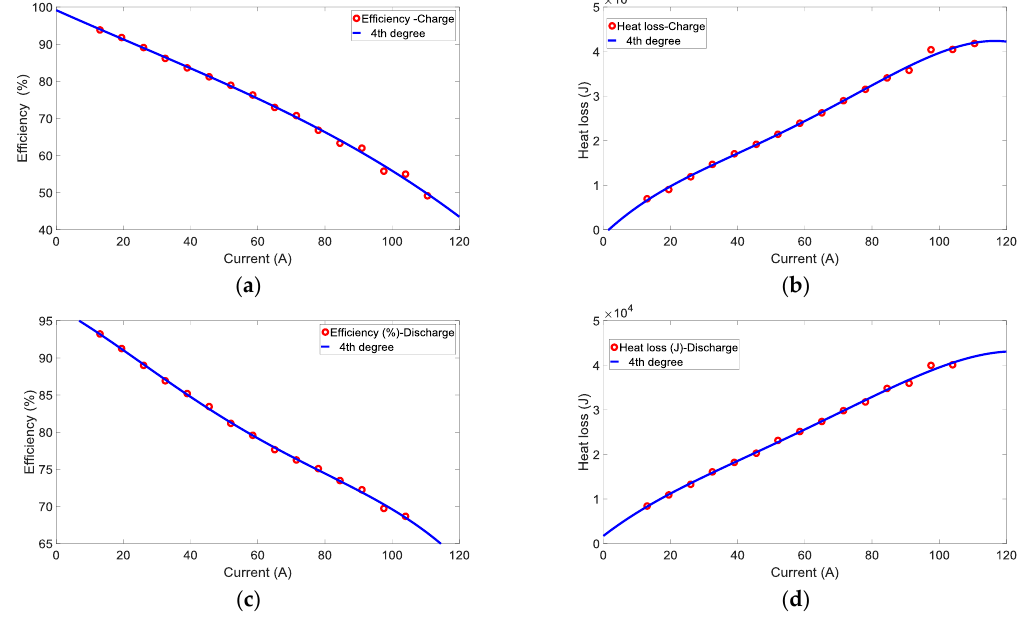
Figure 12. Efficiency and heat loss evolution and their curve fitting during charge and discharge. ( a ) Efficiency-Charge; ( b ) Heat loss-Charge; ( c ) Efficiency-Discharge; ( d ) Heat loss-Discharge.